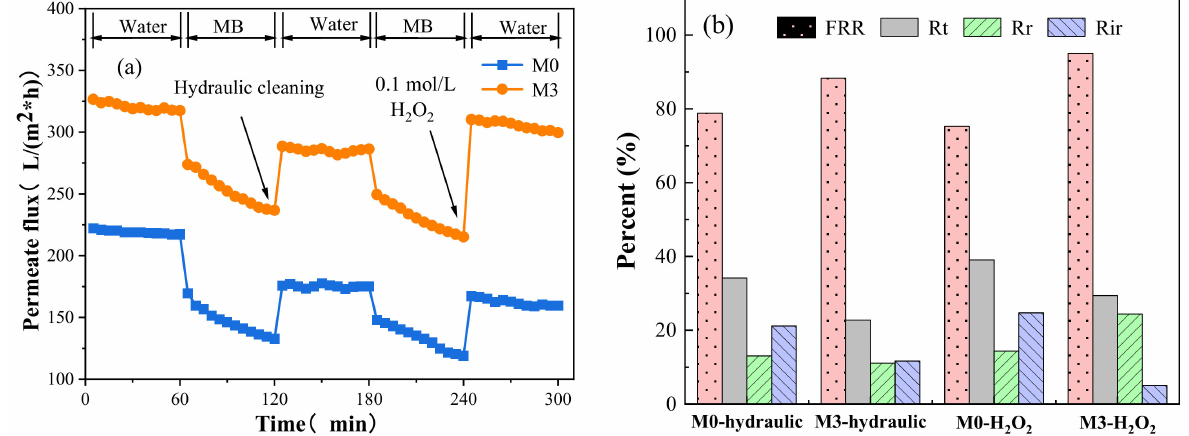
Figure 7. ( a ) Permeation flux of MB solution; ( b ) membrane fouling parameters with hydraulic cleaning or H 2 O 2